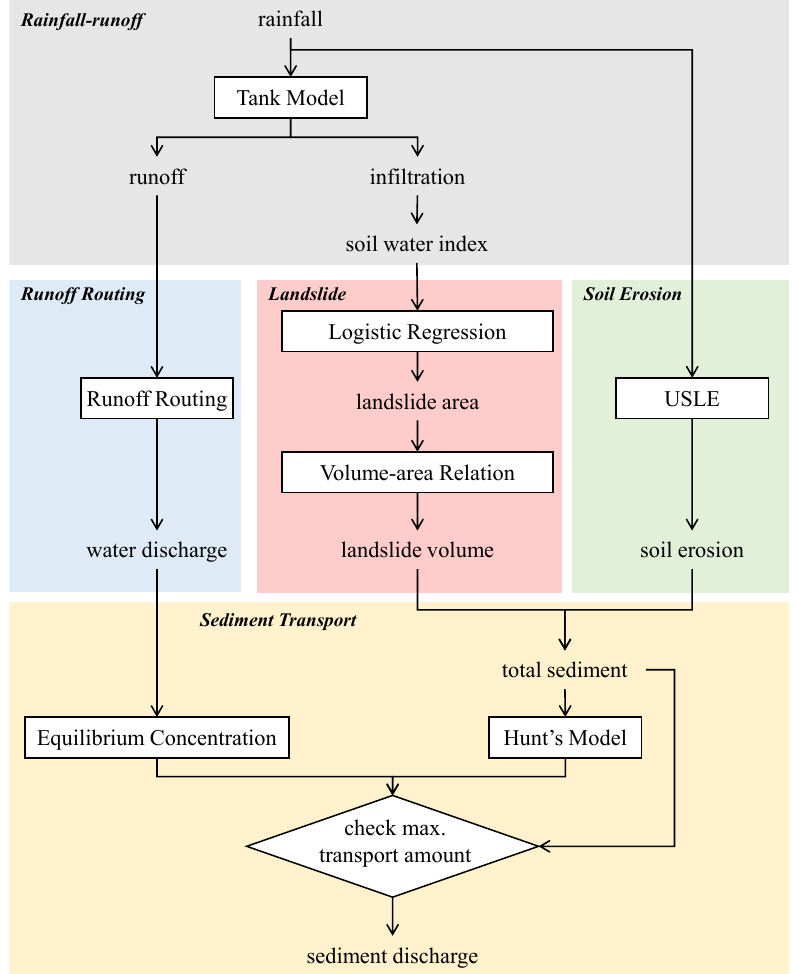
Figure 3. Framework and flowchart of Grid-based Sediment Production and Transport Model (GSPTM). USLE, Universal Soil Loss